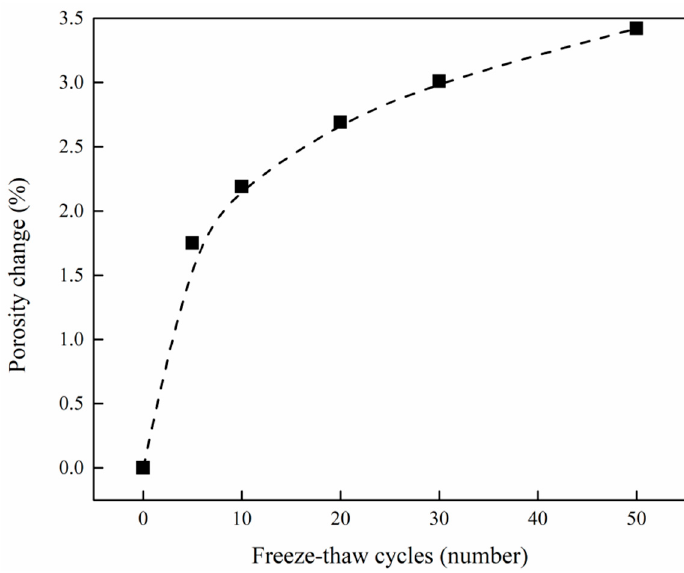
Figure 13. Relationship between freeze–thaw cycles and porosity change.